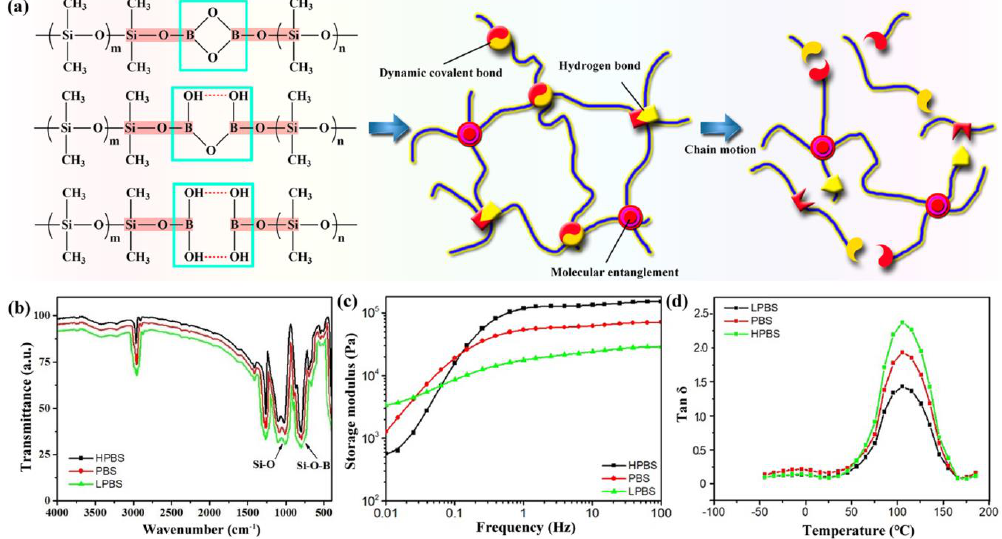
Figure 1. ( a ) The preparation of PBS-gel. ( b ) Fourier transform infrared (FTIR)-ATR spectra of PBS- gel samples. ( c ) Storage modulus (G’) of PBS -gel samples at different frequencies. ( d )